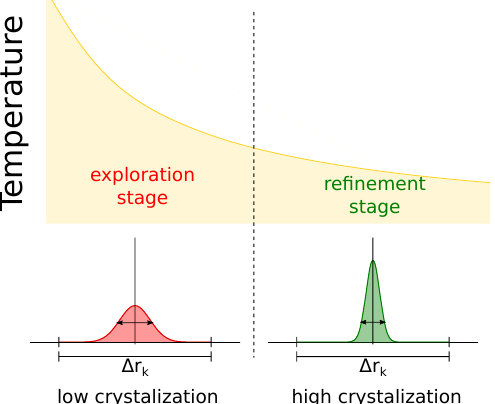
Figure 1. SA has two clear phases in the optimization process: exploration and refinement. The crys- tallization factors have a connection with the two phases. During the exploration phase, larger jumps are performed (the parameters have lower crystallization). During the refinement phase, the opti- mization performs smaller jumps with higher probability (the parameters have higher crystallization). ∆ r k is fixed for each variable and represents the distribution